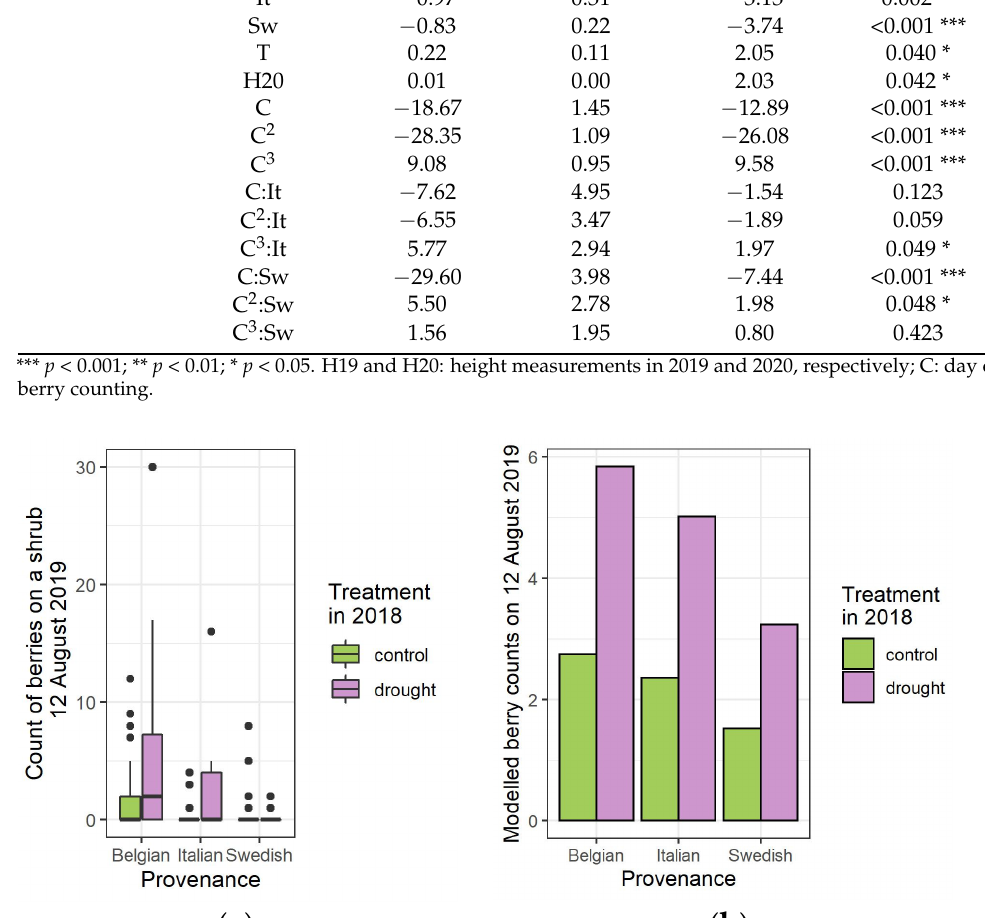
Figure 1. Boxplot representing the height increment of the shrubs in the common garden in 2020, according to the provenances and treatment in 2018.